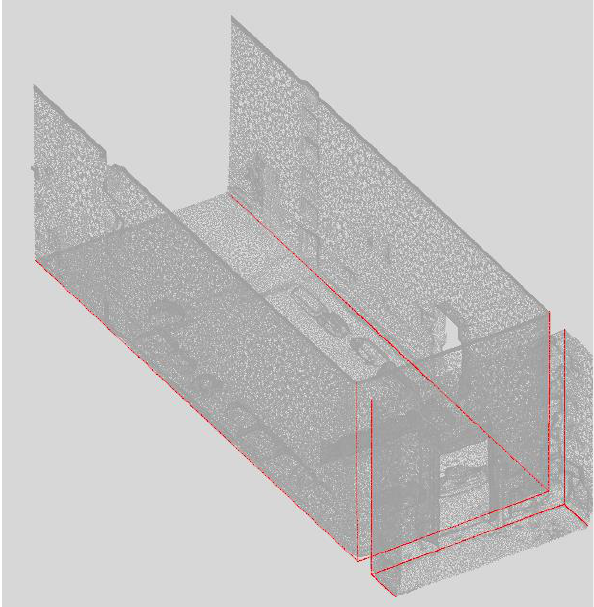
Figure 12. Illustration of the point cloud and edges.